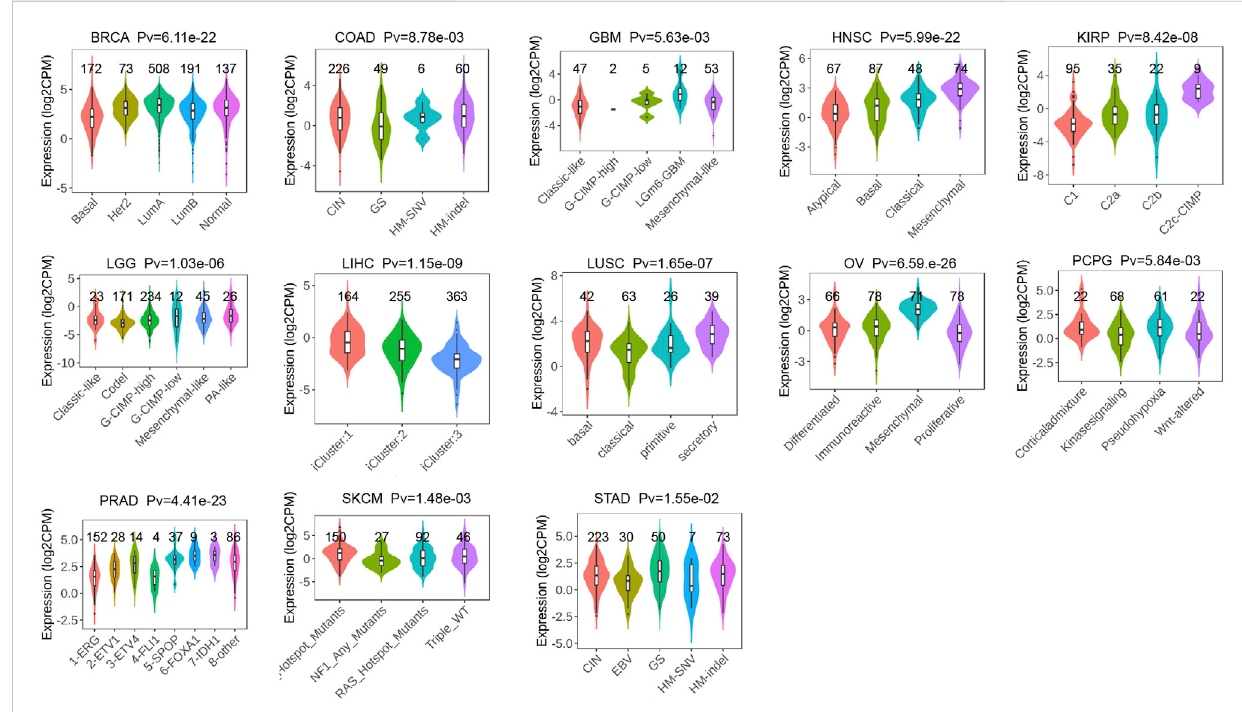
FIGURE 6 The differences of P4HA3 expression levels among distinctive molecular subtypes in BLCA, COAD, GBM, HNSC, KIRP, LGG, LIHC, LUSC, OV, PCPG, PRAD, SKCM, and STAD. The different colors represent the different molecular